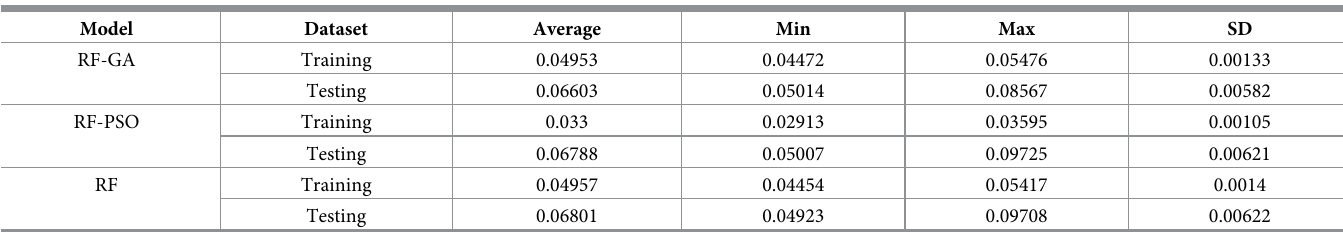
Table 7. Summary of the 1000 simulations using MAE criteria.